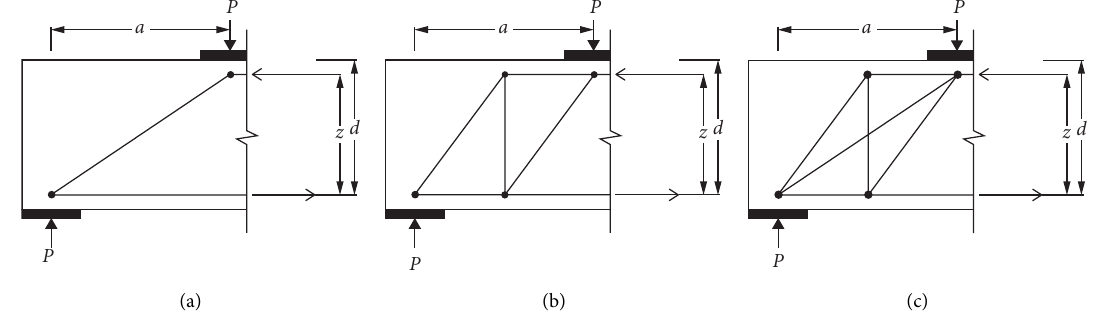
Figure 11: Strut-tie model for single-span deep beams. (a) Arch mechanism. (b) Truss mechanism. (c) Arch and truss mechanism